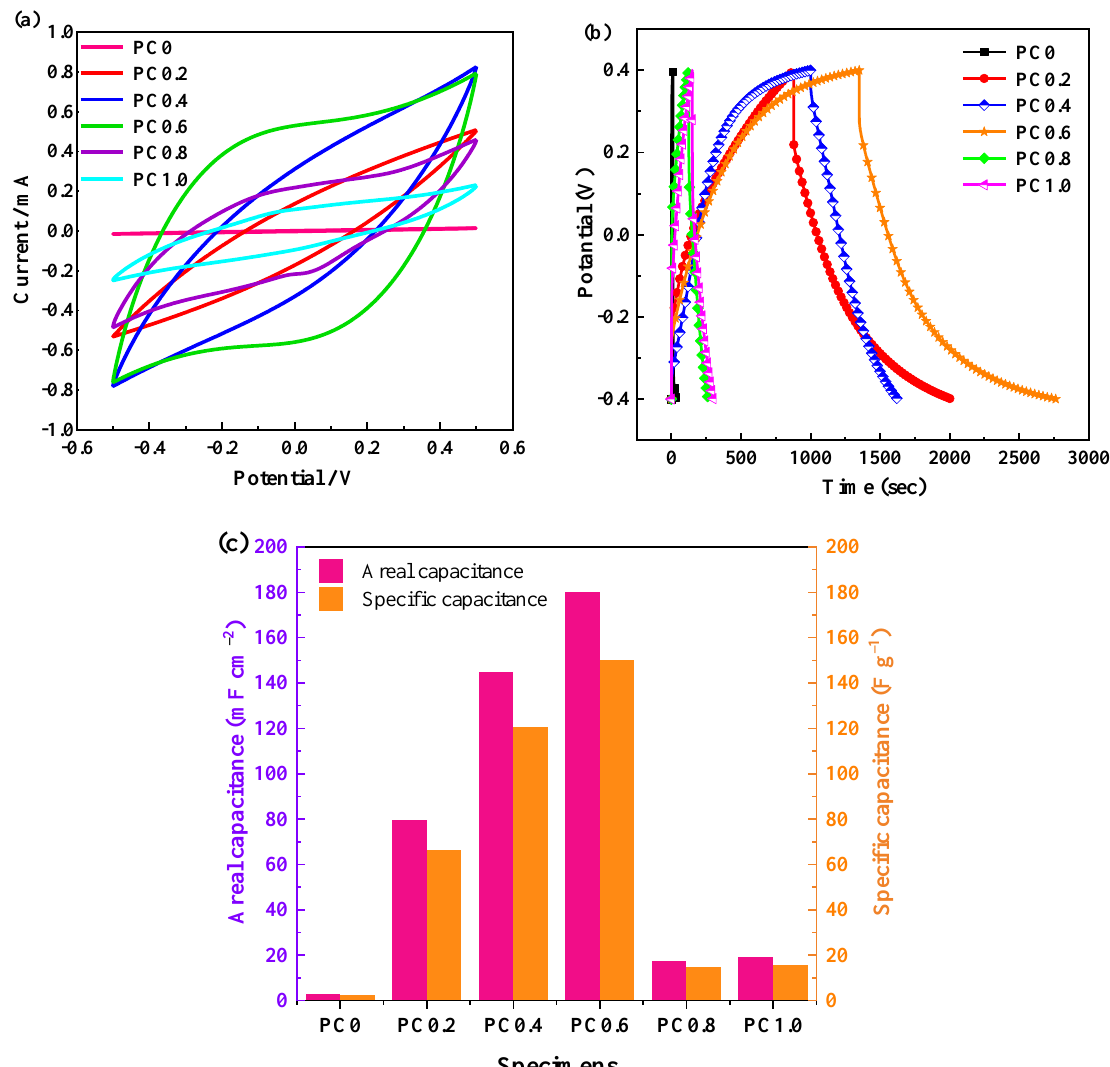
Figure 5. ( a ) CV curves; ( b ) GCD curves; and ( c ) the corresponding areal capacitances and specific capacitance of devices based on different cement pastes.